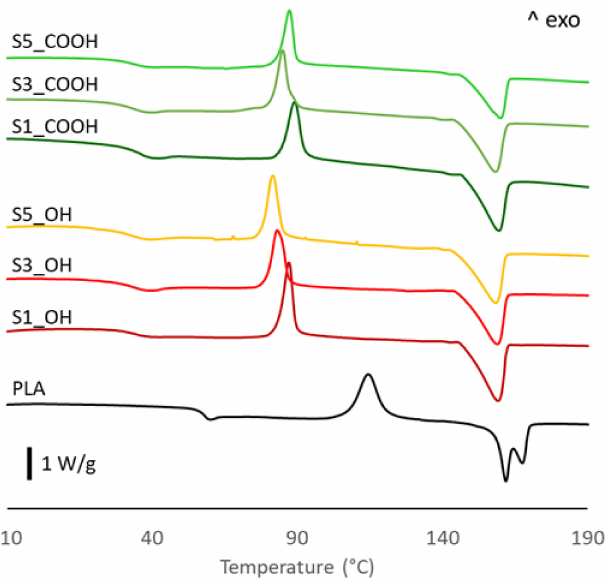
Figure 3. DSC traces of PLA and plasticized